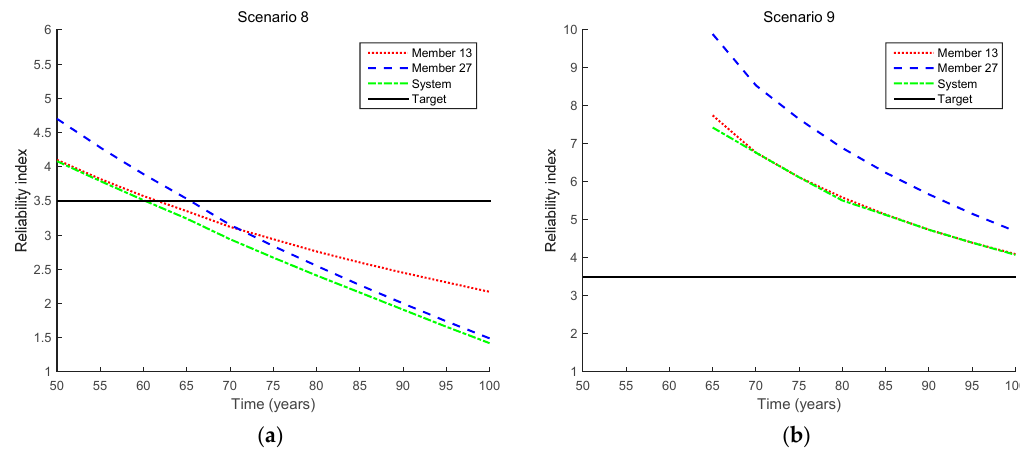
Figure 11. Reliability updating results by the proposed method for inequality cases (Scenarios 8 and 9 in Table 3). ( a ) Scenario 8; ( b ) Scenario 9.